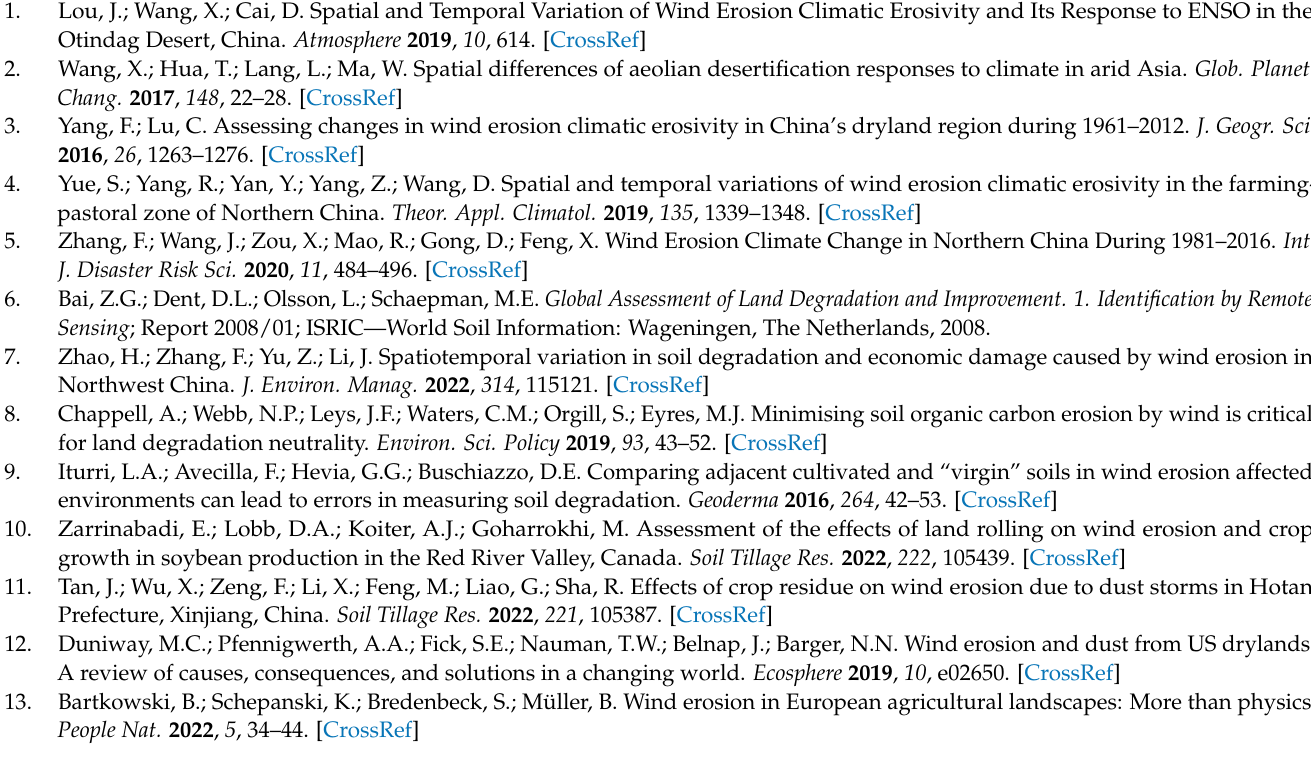
Table S2. SPI for meteorological stations